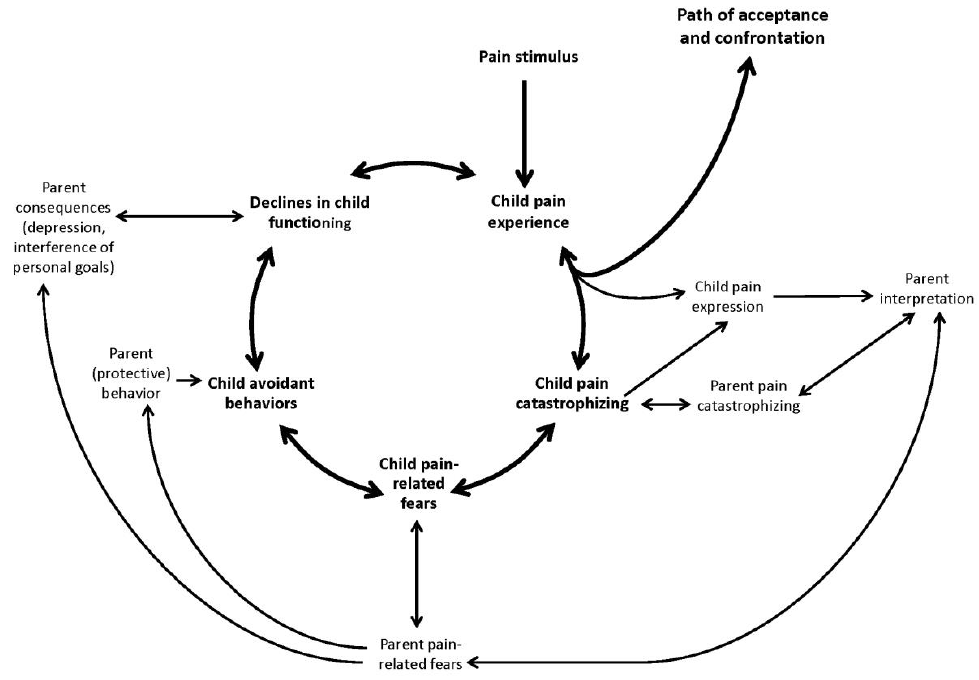
Figure 3. The interpersonal fear-avoidance model of chronic pain. Reprinted from Simons, L.; Smith, A.; Kaczynski, K.; Basch, M. Living in fear of your child’s pain: The parent fear of pain questionnaire [38].